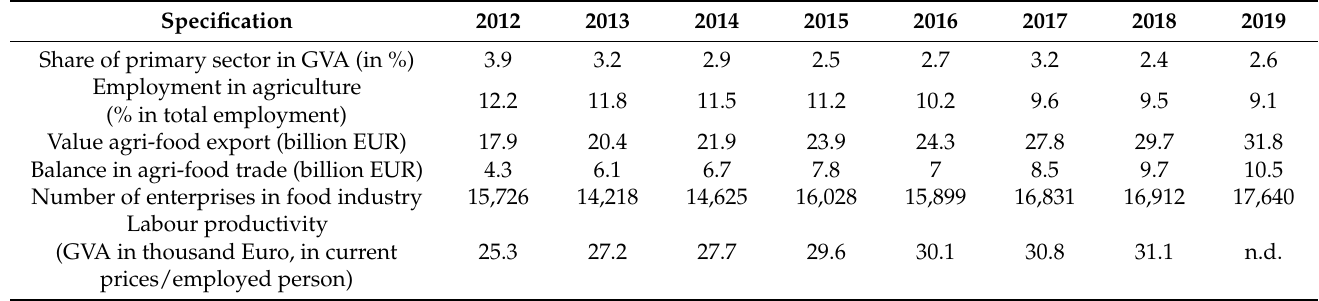
Table 1. Selected characteristics of the Polish agri-food sector,